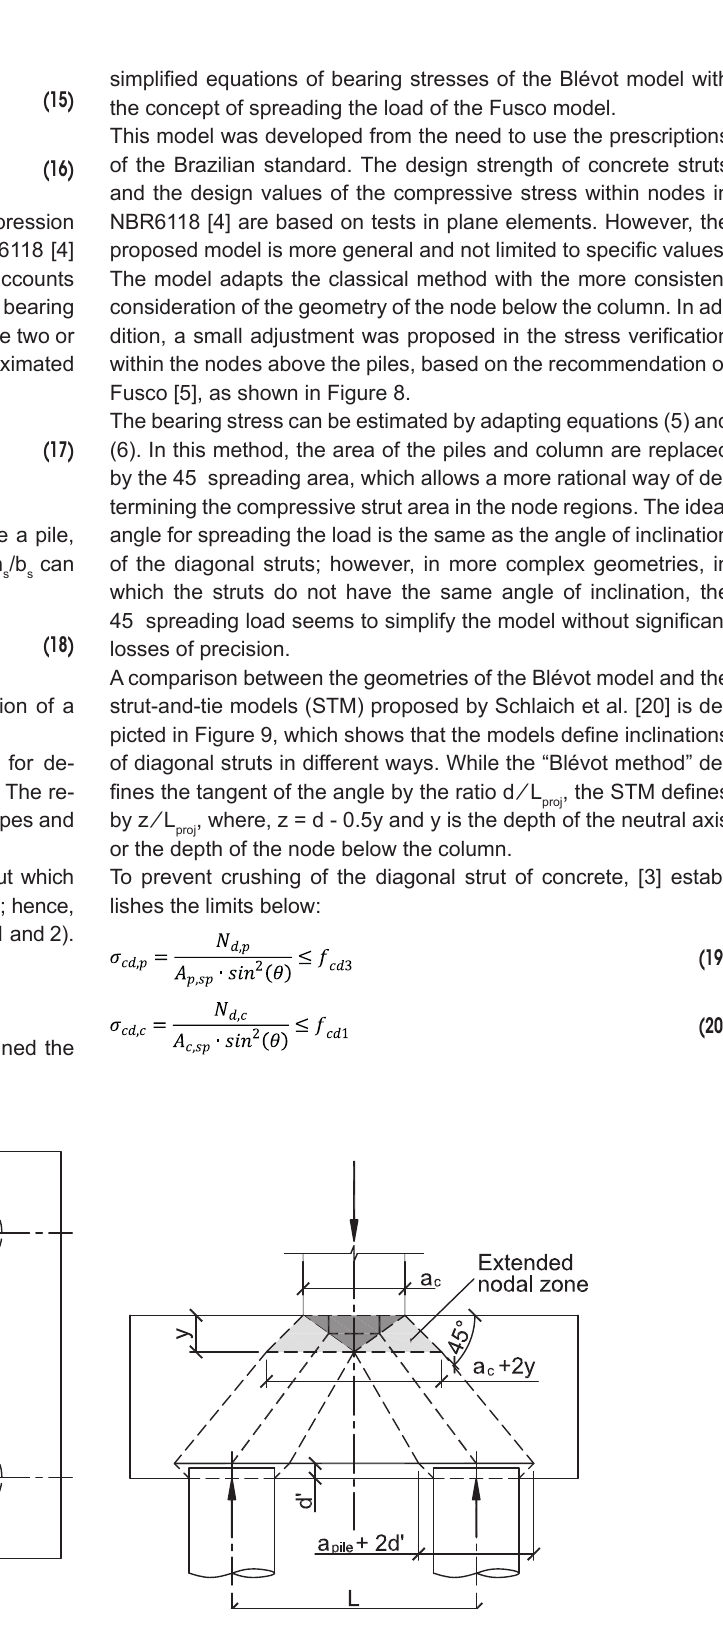
Figure 8 Strut-and-tie model with the compressive node inside the pile cap (SANTOS et al.